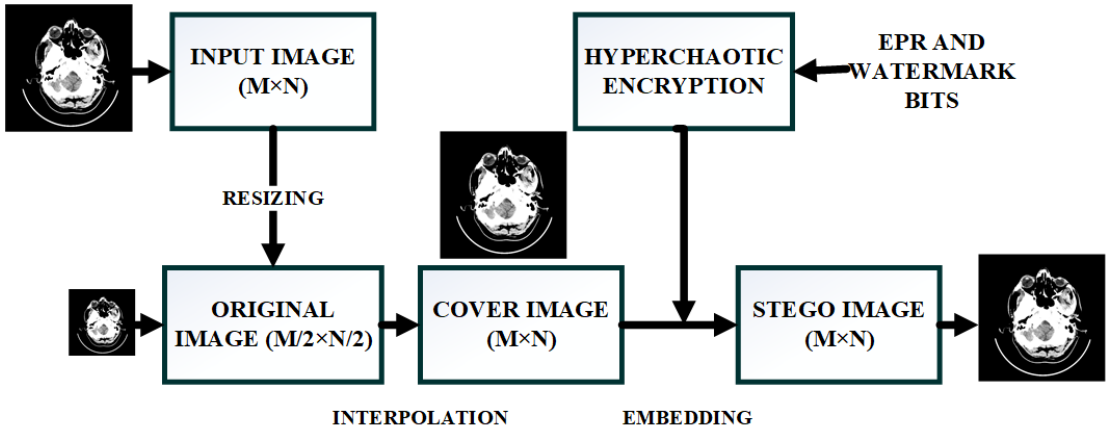
Figure 1. A detailed sequence of operations for the presented method.